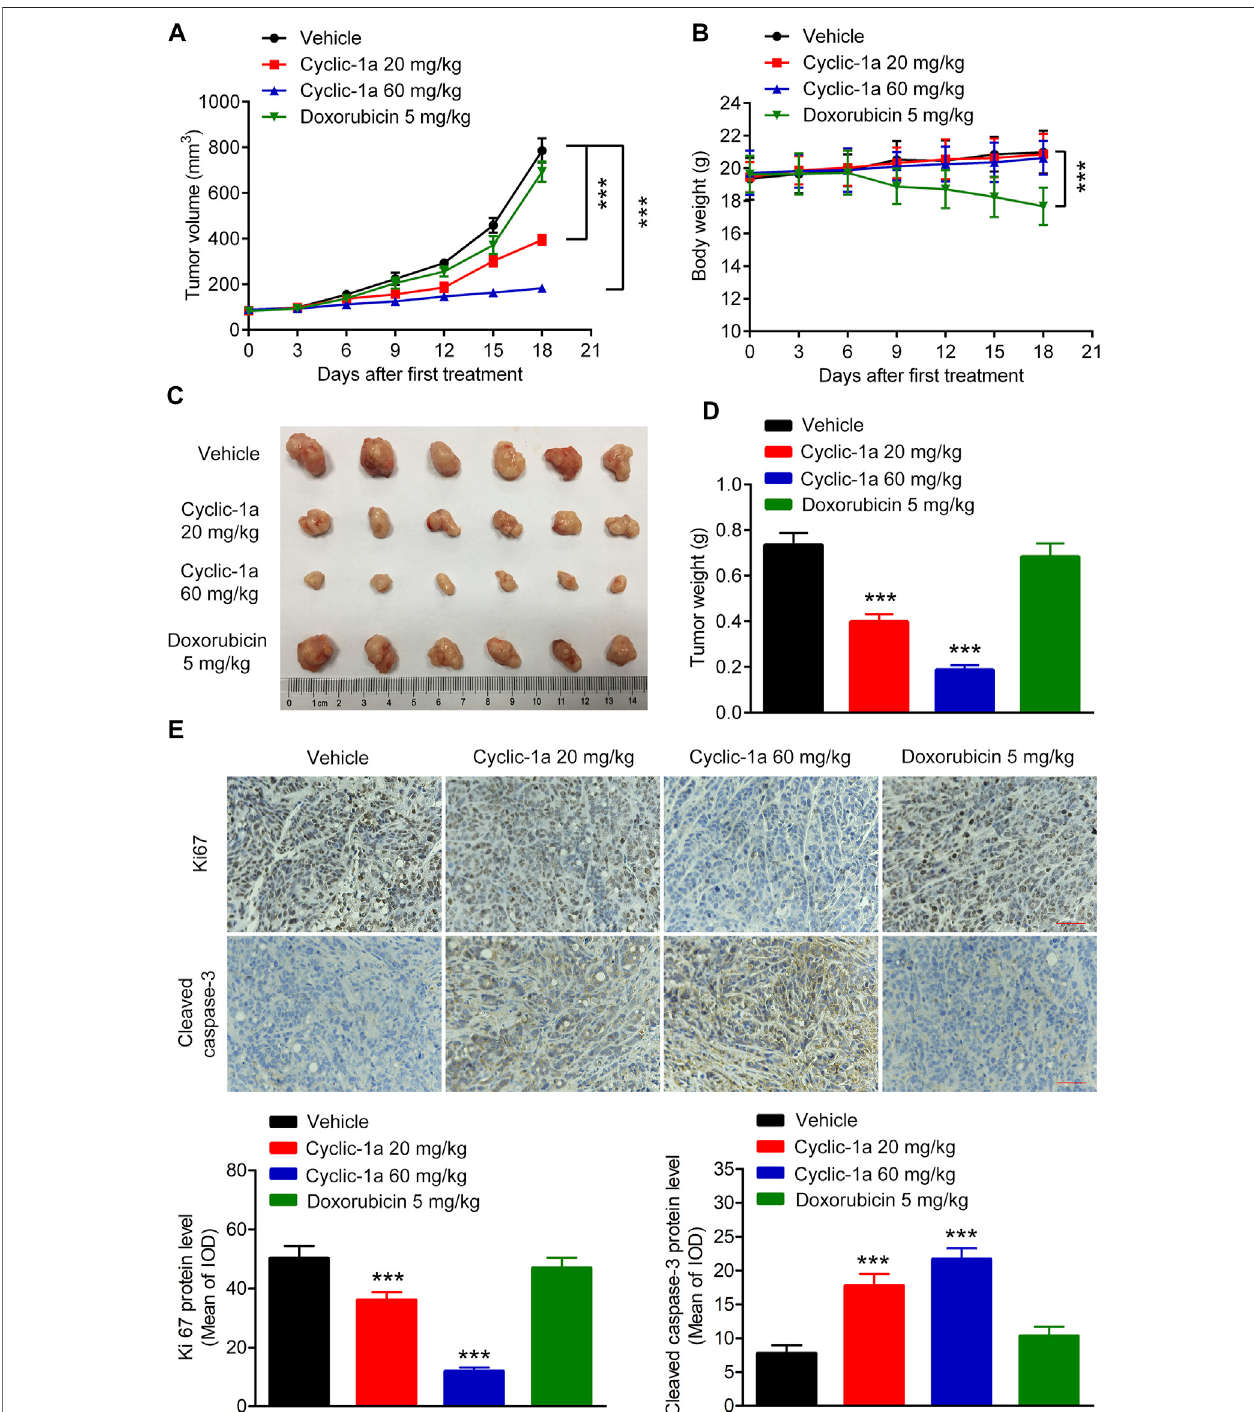
FIGURE5| Invivo antitumoreffectofcyclic-1a. (A) Thetumorvolumechanges. (B) Thebodyweightchanges. (C) Theimageoftumors. (D) Thetumorweights. (E) The protein levels of Ki67 and cleaved caspase-3 in tumors (Scale bar (cid:1) 50 μ m). Data are represented as mean ± SD, n (cid:1) 6. *** p < 0.001 vs vehicle group.